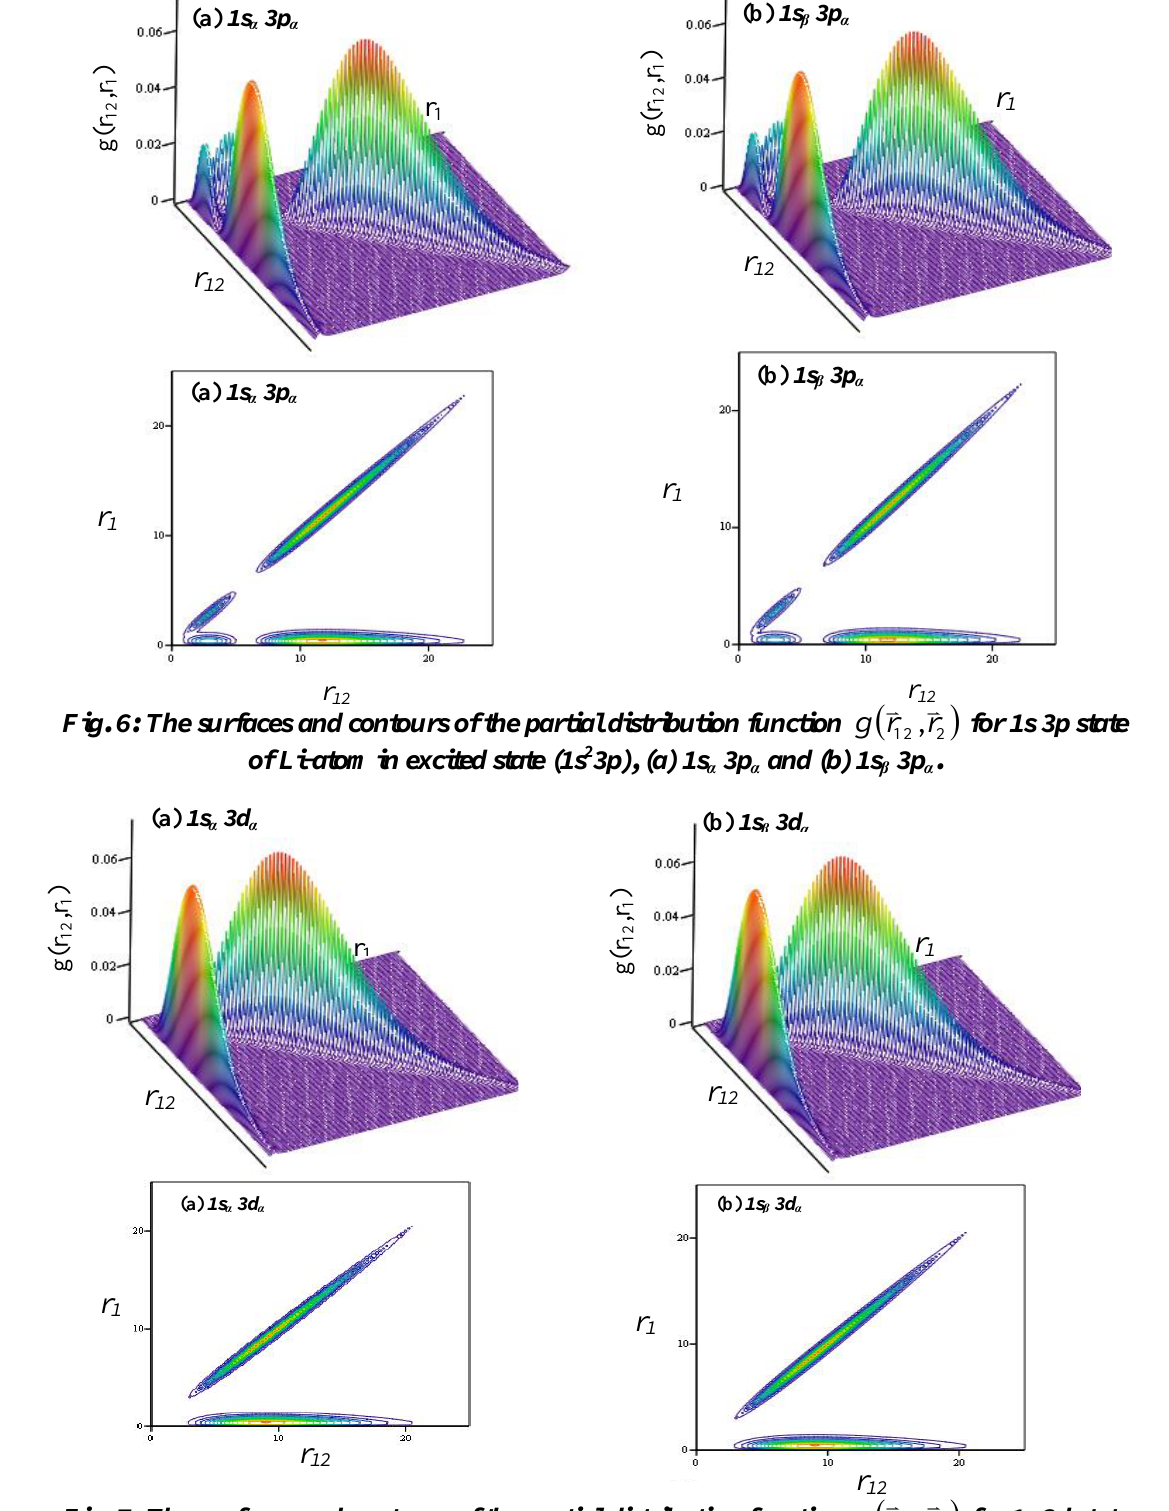
Fig. 7: The surfaces and contours of the partial distribution function  